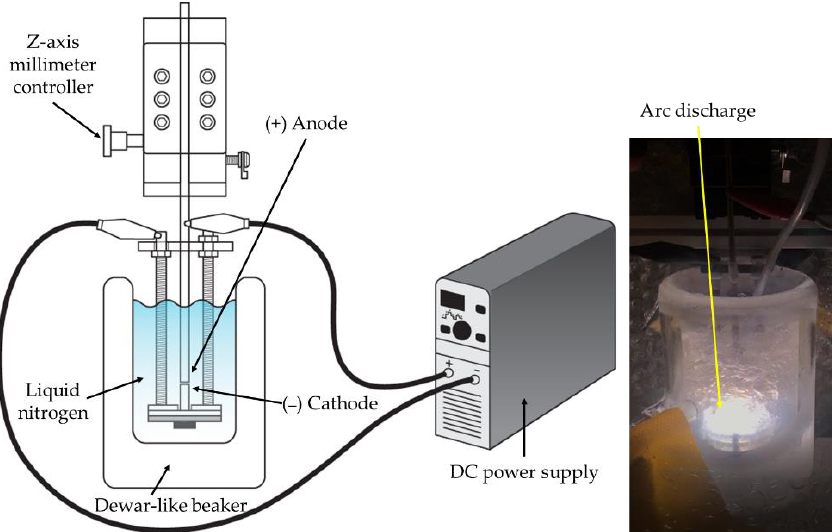
Figure 2. Schematic of experimental setup ( left ) and actual picture of arc discharge in liquid nitrogen ( right ). Table 1. Detailed operating